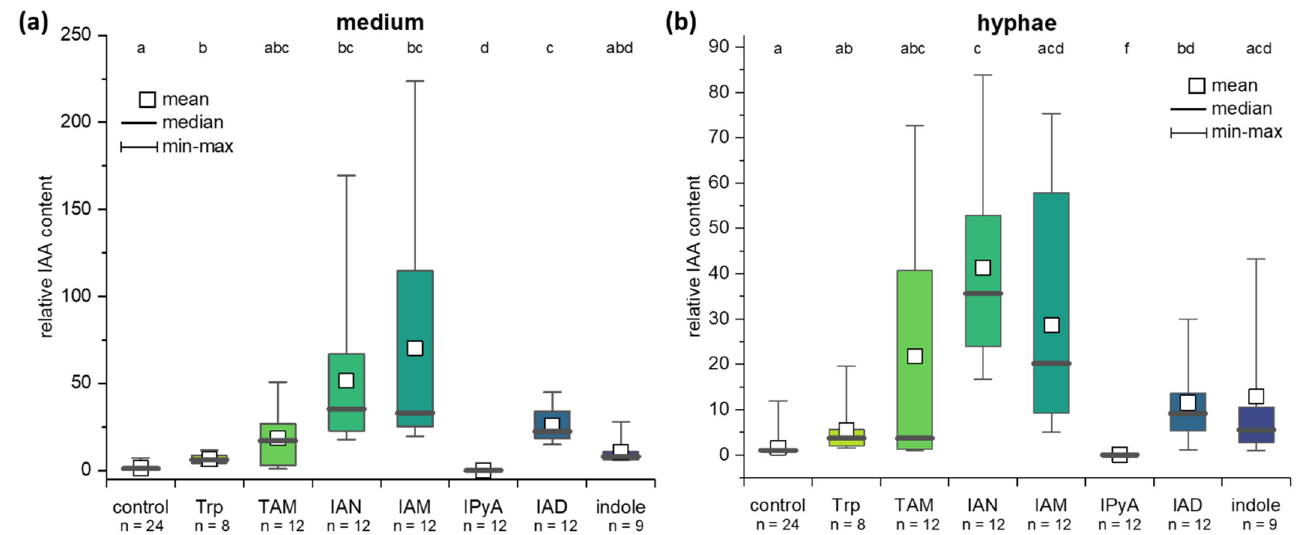
Figure 4. IAA levels in medium and hyphae of C. asteris after feeding with different IAA precursors. C. asteris was cultivated in MEAlow for seven days, before IAA precursors (Trp, TAM, IAN, IAM, IPyA, IAD, or indole) were added to the culture. IAA levels were detected after 10 days of cultivation (3 days with precursors). The IAA level in ( a ) medium and ( b ) hyphae of C. asteris is correlated to the respective control (without any IAA precursor), which is set to 1. Small letters above the box plots show the statistical significance; test statistics can be found in Table S2. Sample size n is given below the x-axis.